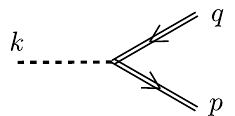
Figure 1 . Feynman diagram for pseudoscalar-seeded electron-positron pair